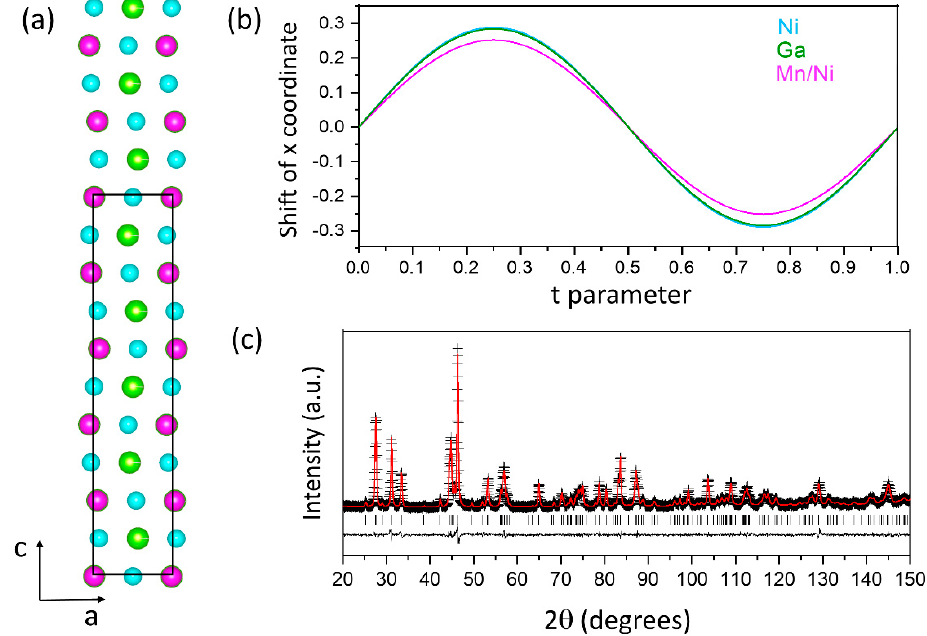
Figure 3. ( a ) View of the incommensurate modulated structure of the Ni 2.07 Mn 0.93 Ga martensitic phase. ( b ) Sinusoidal displacement of the atomic positions obtained by the Rietveld refinement of the (3+1)-dimensional model. The t parameter is related to the x 4 coordinate. ( c ) Rietveld plot of the structural refinement for the modulated martensite at 220 K.